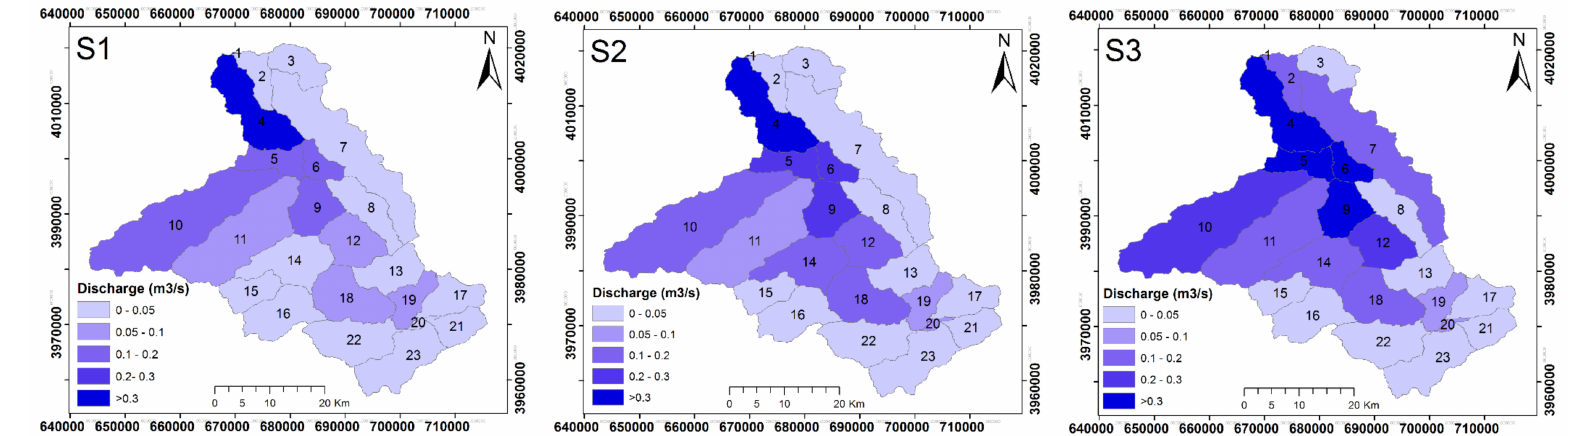
Figure 8. Changes in average annual discharge yield in sub-basins for three land use scenarios (S1, S2 and S3).